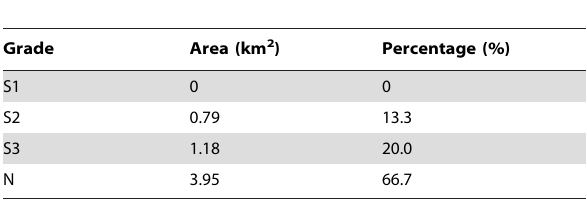
Table 12. Areas of land suitable for forest growth in the Liudaogou